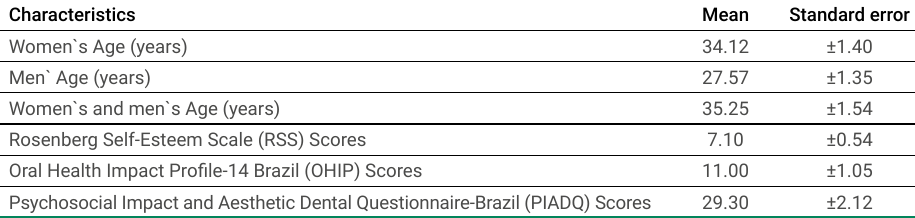
Table 1. Sample characterization regarding age, income and questionnaires’ scores. Characteristics